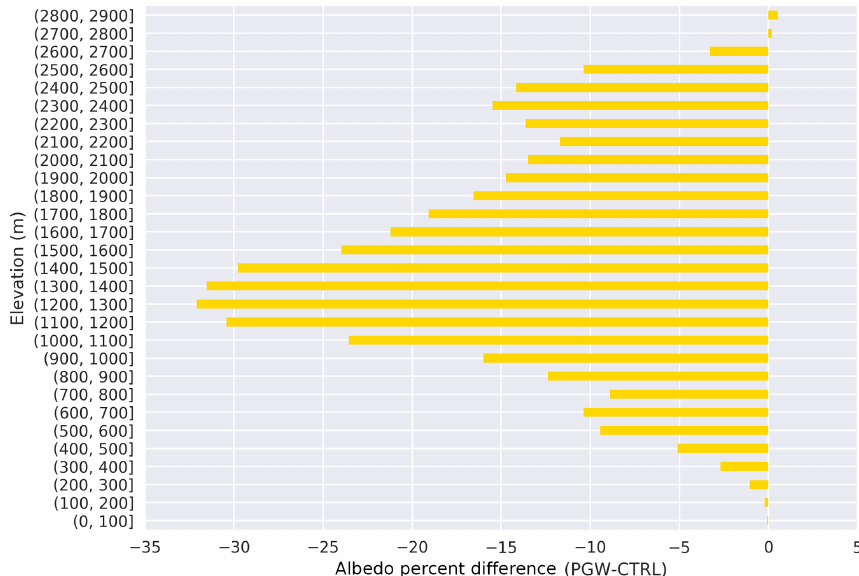
Figure 9. Surface albedo percentage difference (PGW–CTRL) within the study area binned at 100m intervals from 0–3000m over the January–April 2010 period.